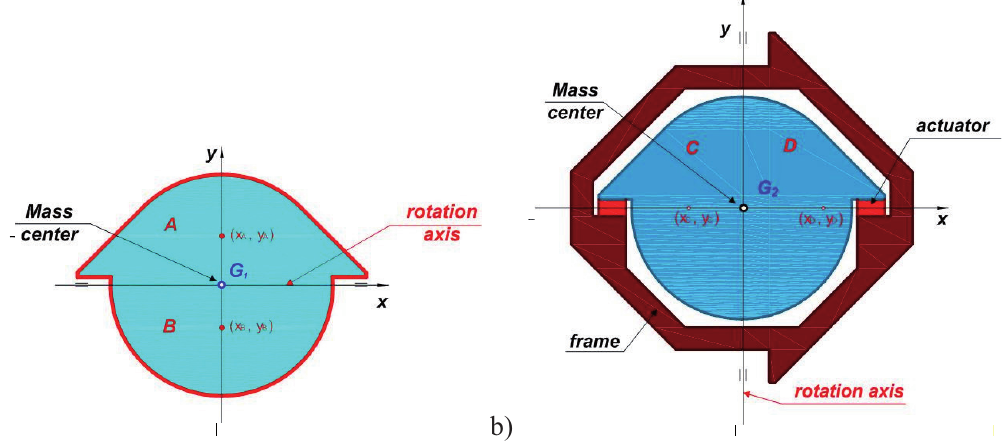
Fig. 4. Mass and geometrical parameters of two elements: a) resonance element (mirror), b) non-resonance element (mirror + frame).